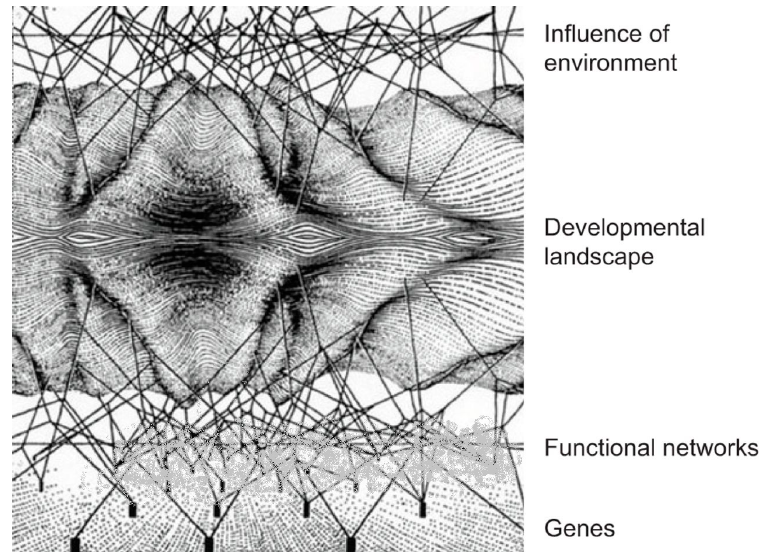
Figure 2. Development of Waddington’s (1957) landscape diagram [43]. The original diagram was simply the lower half of this diagram, which Waddington used to indicate that the developmental phenotype (the landscape) is not directly dependent on the genes (the pegs at the bottom) but also depends on the regulatory networks represented as lying in between genes and the phenotype. Our version of the diagram incorporates two new features. First, organisms are open systems sensitive to the environment. This is represented by the top half of the diagram. Second, the regulatory networks in the lower half (the original half) of the diagram act to buffer genetic variation. This is represented by a ‘cloud’ covering a large fraction of the genome, corresponding to the fact that many mutations at the genome level are silent functionally. The regulatory networks can buffer many variations at the genome level. The filtering action of the ‘cloud’ performs a function similar to that of the ‘hold’ mechanism in this article. Differential mutation rates are not therefore essential to enable organisms to guide their own evolution.